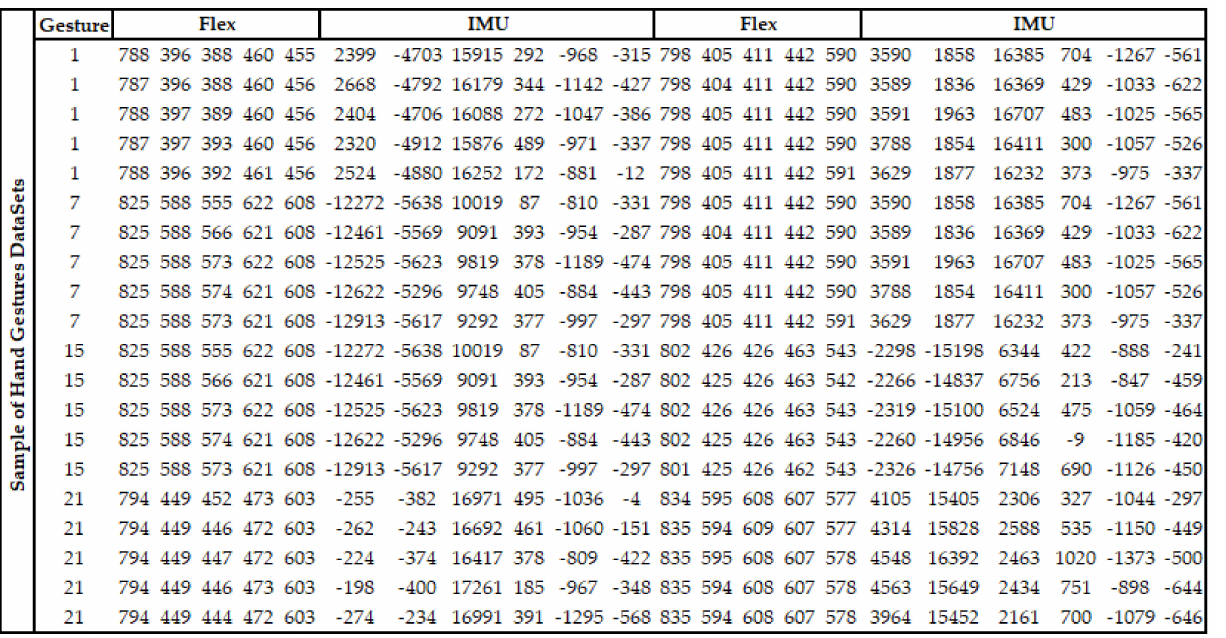
Figure 3. Sample data from the constructed hand gestures for four